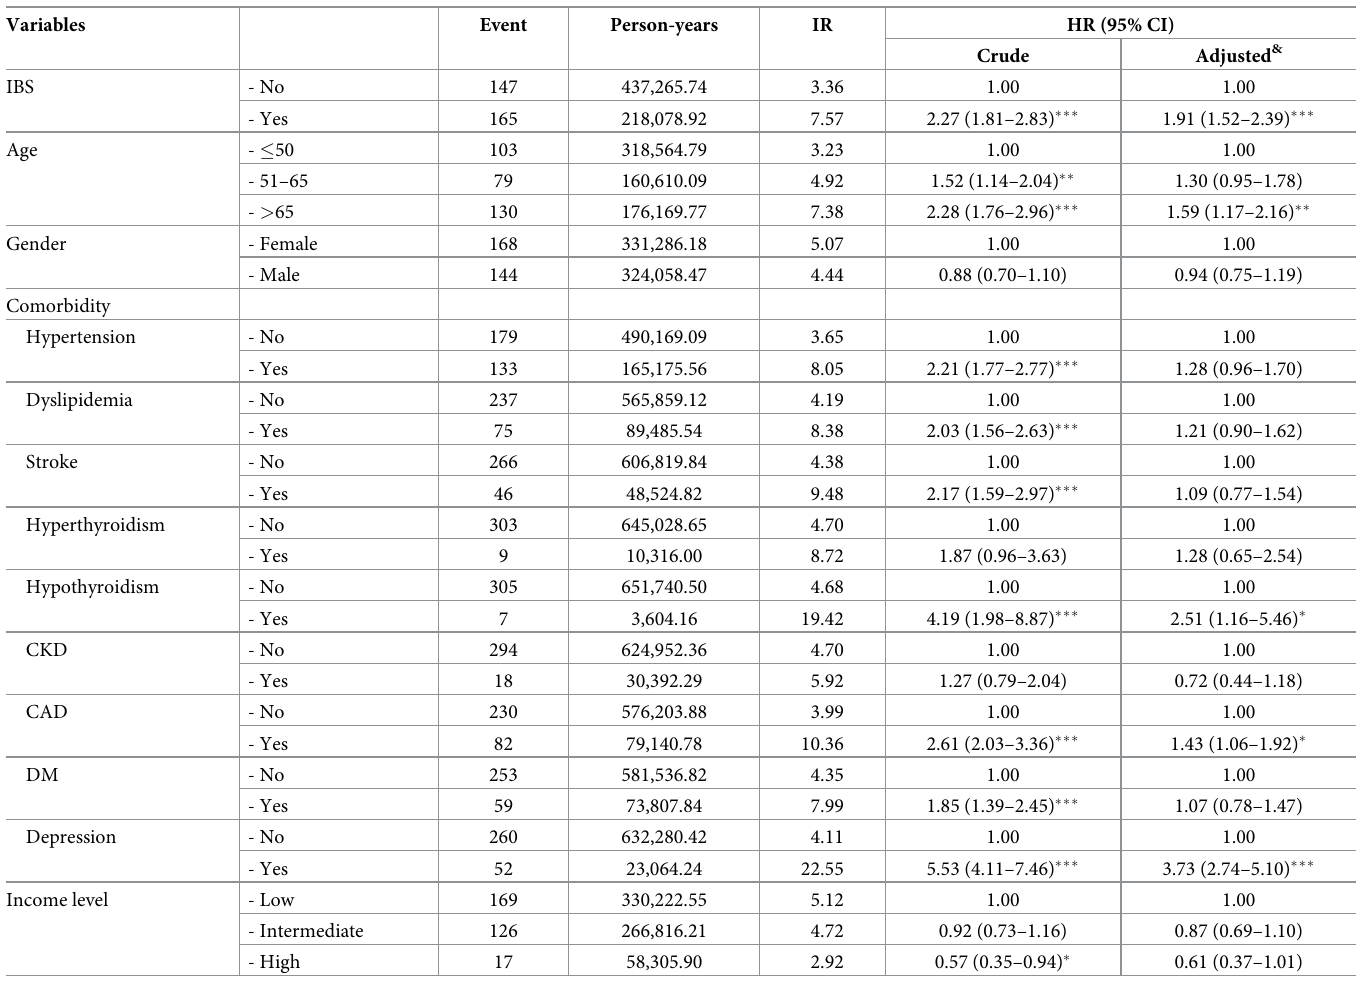
Table 2. Cox model measured HRs and 95% CIs of the RLS associated with IBS and